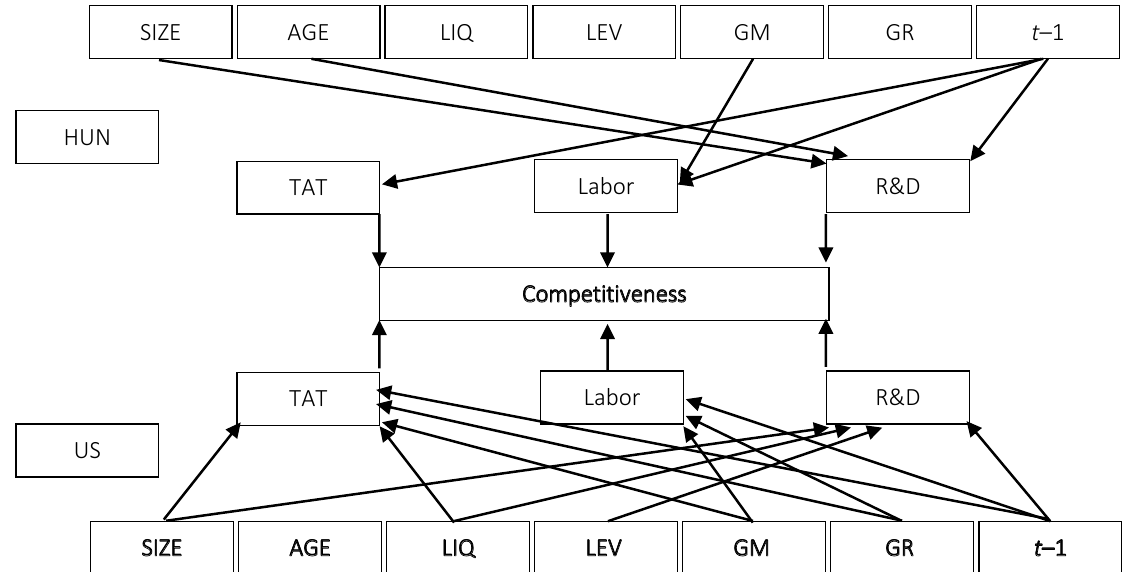
Figure 2. Relation of dependent and independent variables in the two datasets-based